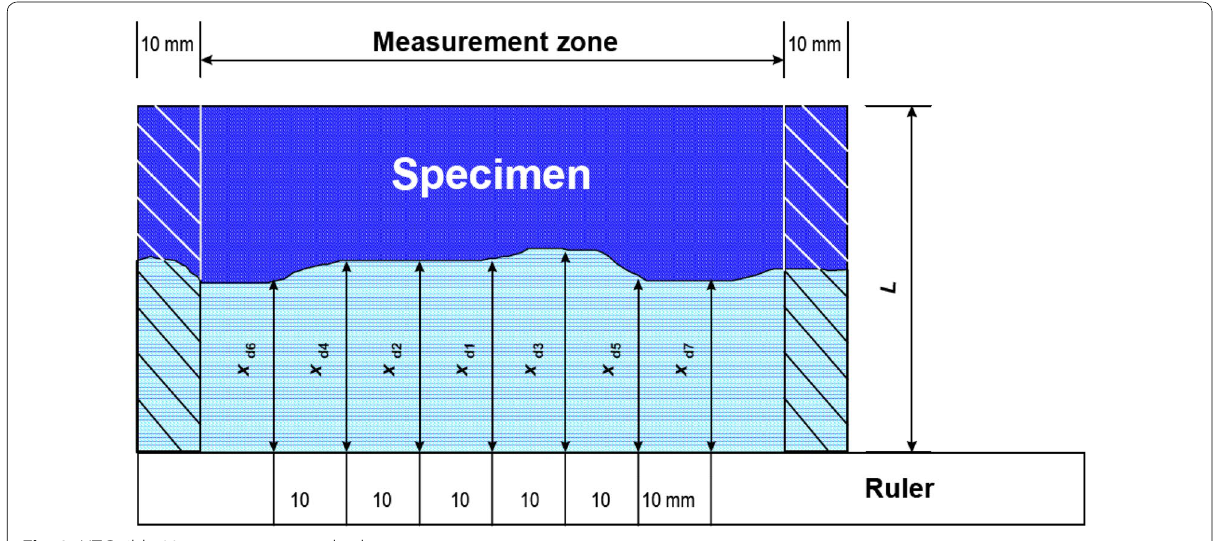
Fig. 3 NT Build 492 measurement method.